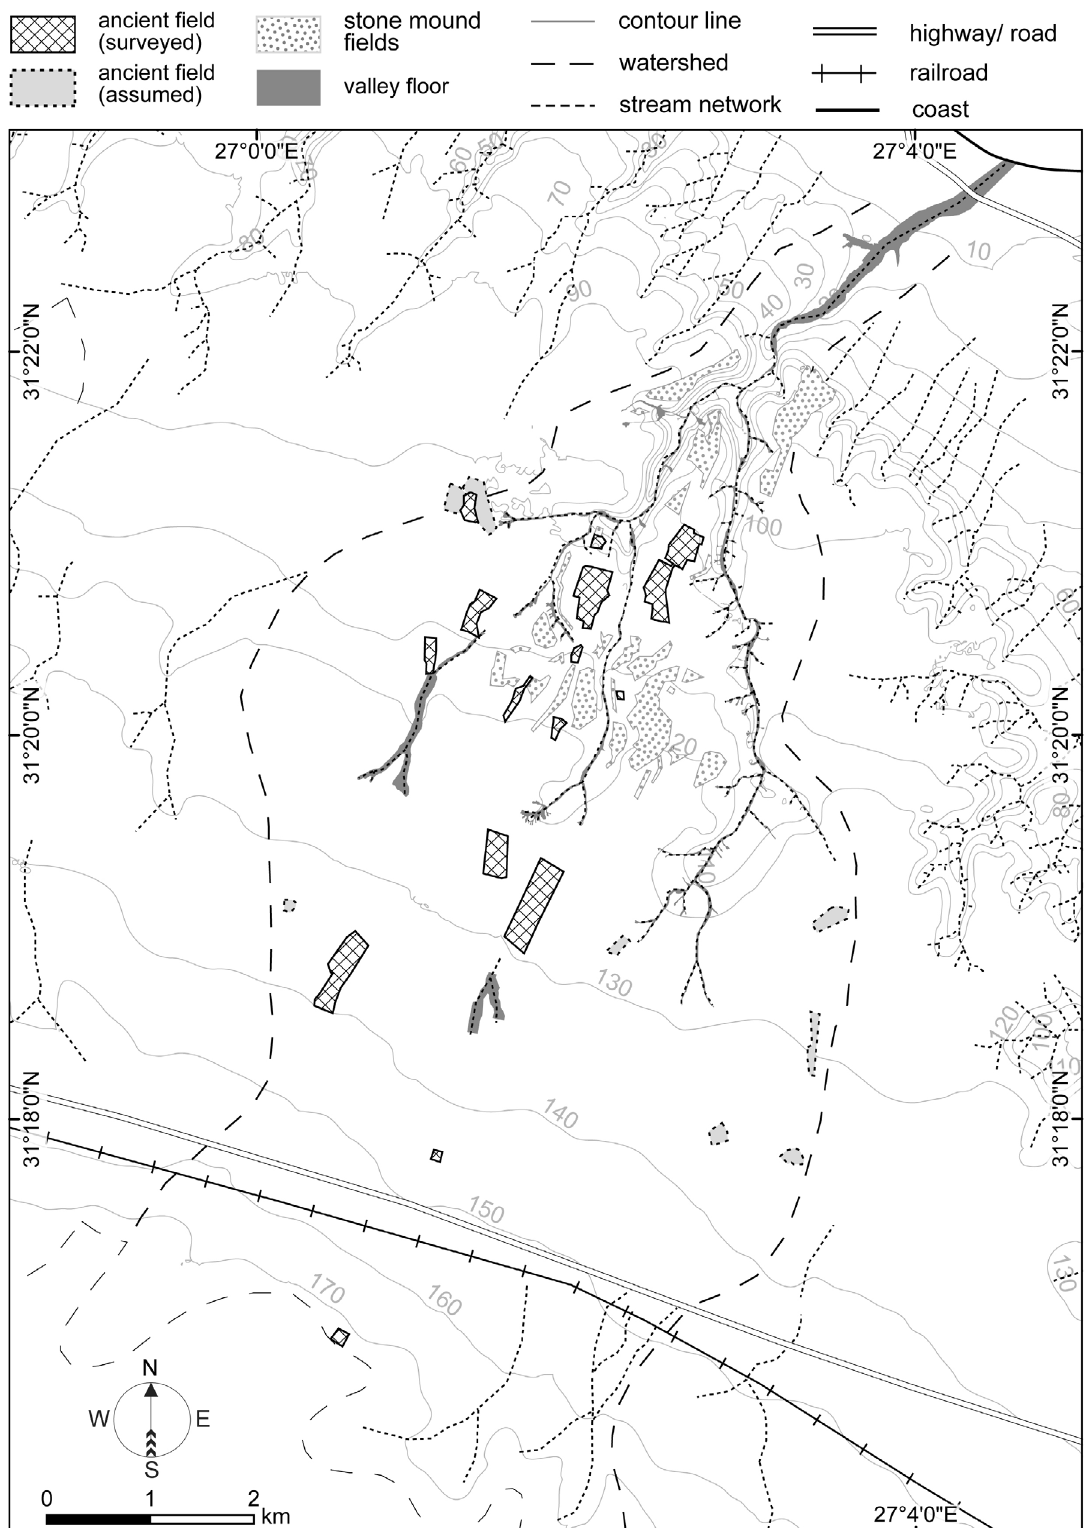
Tableland. (Alexander